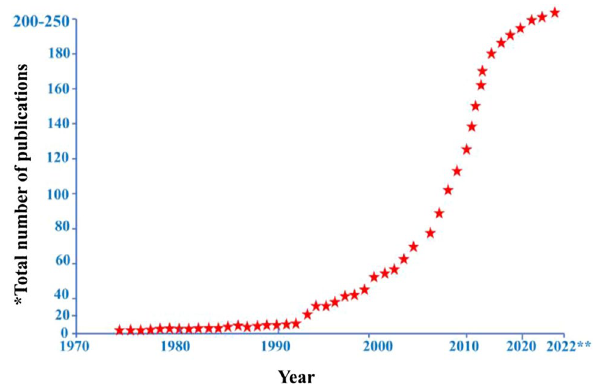
Fig. 2 Statistics of publications on coagulants derived from the plants in water treatment. (*Information attained from the database of Sco- pus and web of science, ** Publication till February